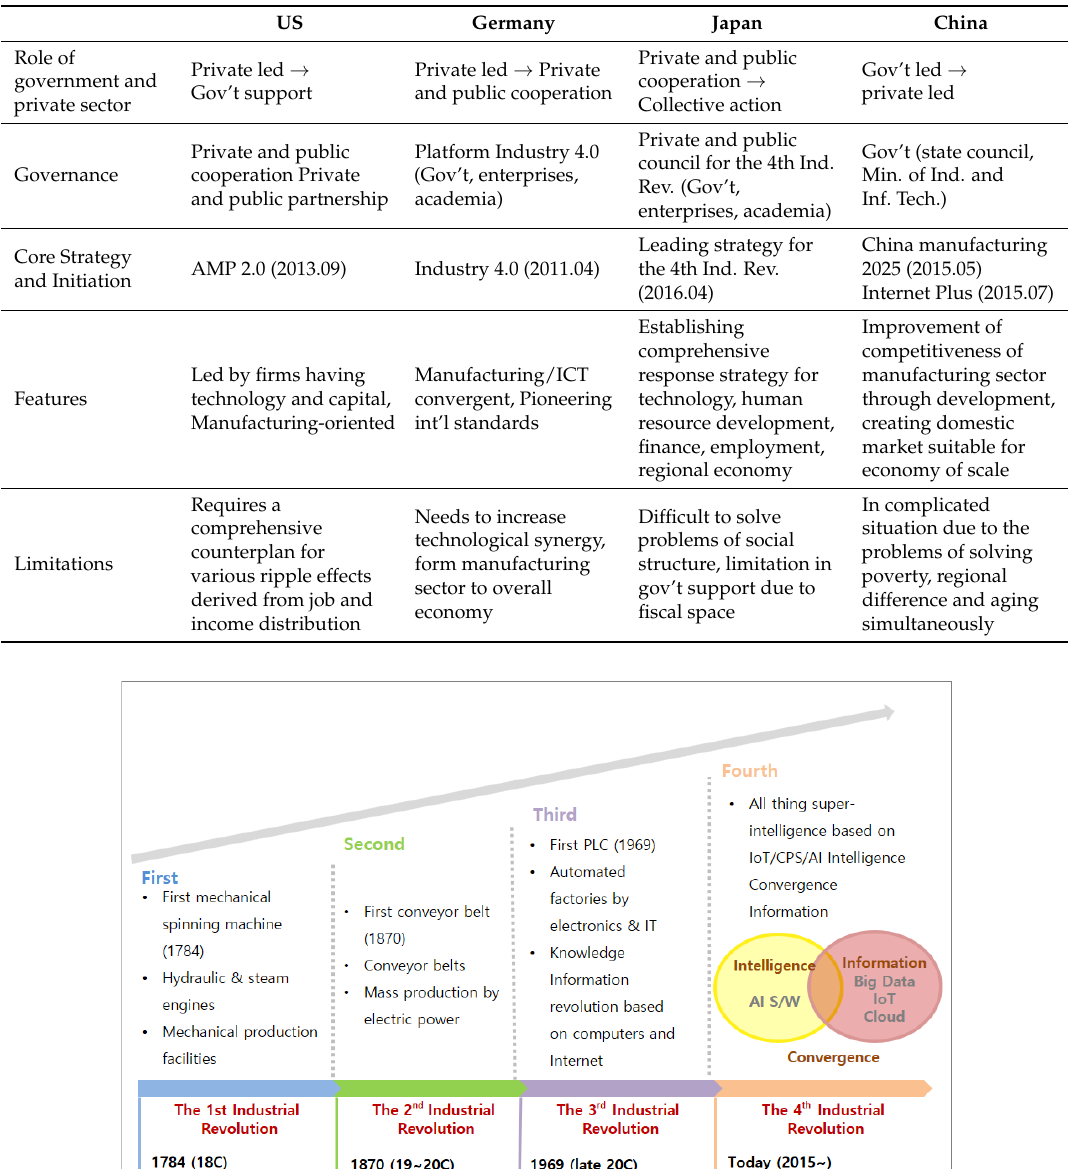
Table 1. Comparison of counterplans for the 4th Industrial Revolution by major industrial nations.